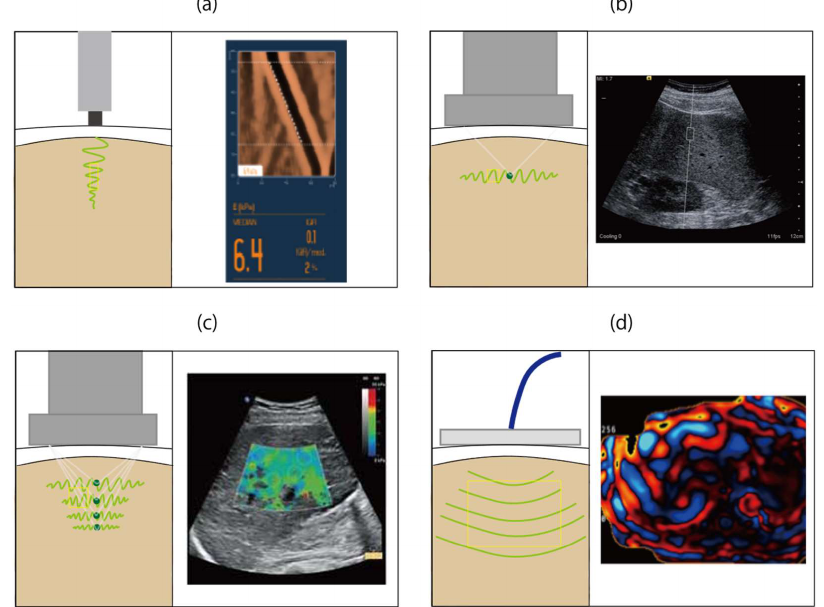
Figure 2. Illustrations and images of each elastography technique. ( a ) Vibration-controlled transient elastography transmits a mechanical pulse from the probe to the liver. ( b ) Point shear wave elastography and ( c ) two-dimensional shear wave elastography use acoustic radiation force impulse (green dots) to induce shear waves in liver tissue. ( d ) Magnetic resonance elastography uses a driver system to generate and transmit longitudinal waves into the liver. The green-yellow wave lines ( a , b , c ) show shear waves, and the curved lines ( d ) show vibrations in the liver. The yellow rectangles indicate the interrogated liver